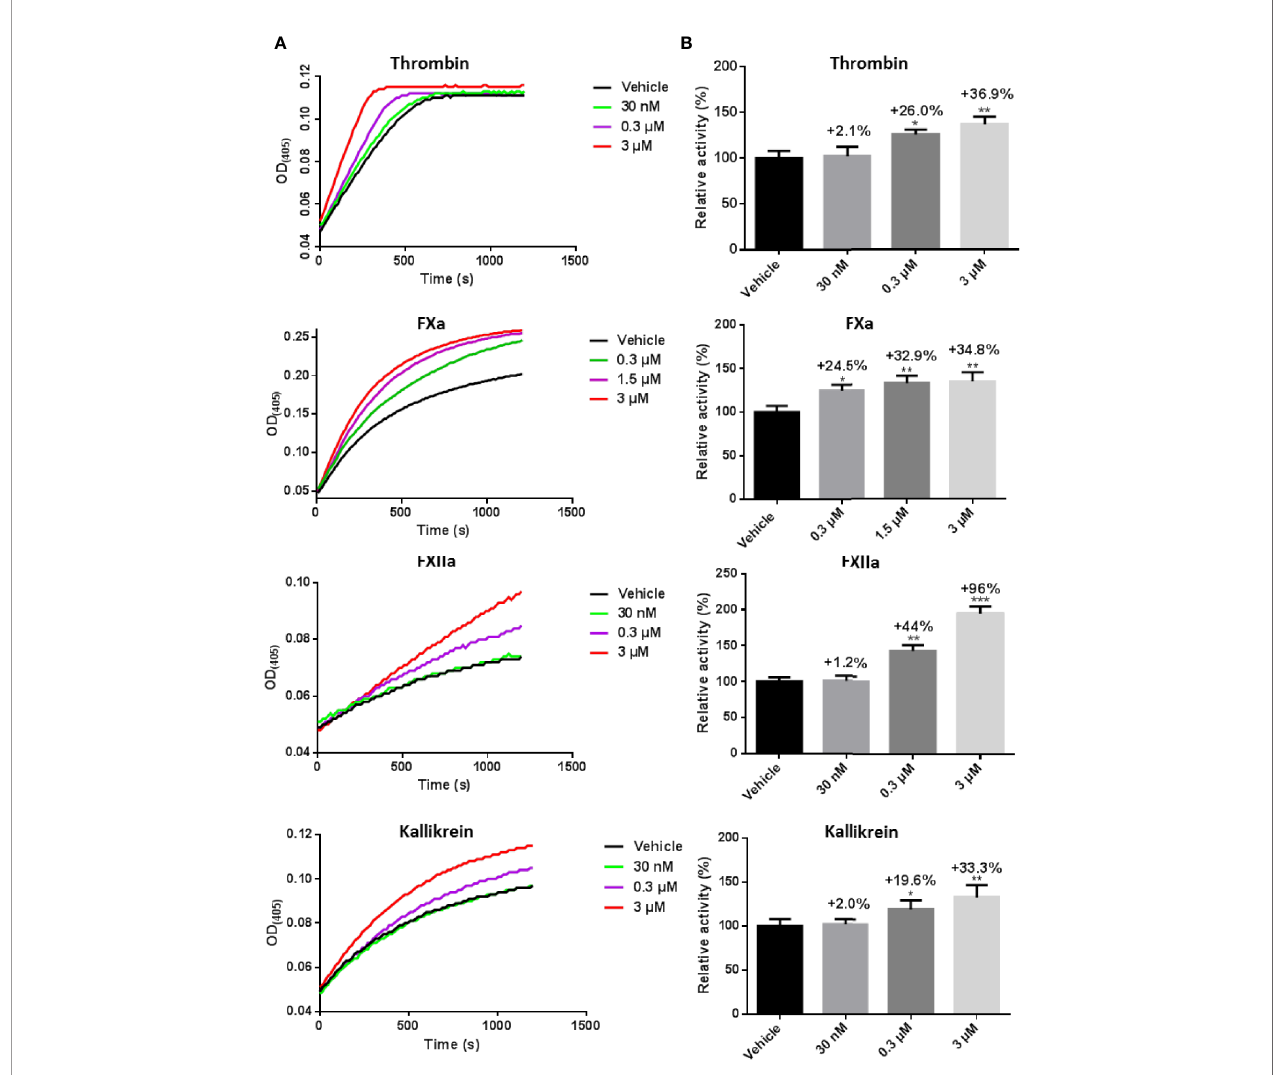
FIGURE 3 | LCTX-F2 increased the activity of coagulation factors. (A) After incubating with 0.03, 0.3, and 3 µM LCTX-F2, the activities of thrombin, FXa, FXIIa, and kallikrein were evaluated with the corresponding chromogenic substrates for 20 min. Relative activity was calculated through enzymatic reactions. (B) Histogram depicting the percent increases in coagulation factor activity stimulated by LCTX-F2. Data are presented as means ± SD of three independent experiments. * P < 0.05, ** P < 0.01 compared with vehicle as determined by the two-sample Student ’ s t